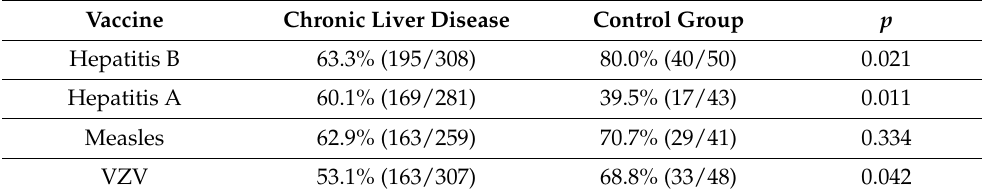
Table 4. Prevalence of seropositive rates of IgG antibodies before transplantation in infants aged 6 months and older. Data is expressed as percentage of protective titers (number of age-appropriate vaccinated children/total number of investigated children).